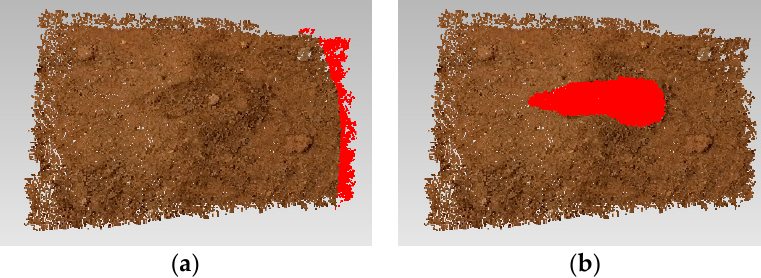
Figure 7. Differential region in C 1 compared with C 0 , ( a ) Caused by a trajectory difference; ( b ) Caused by soil collection.